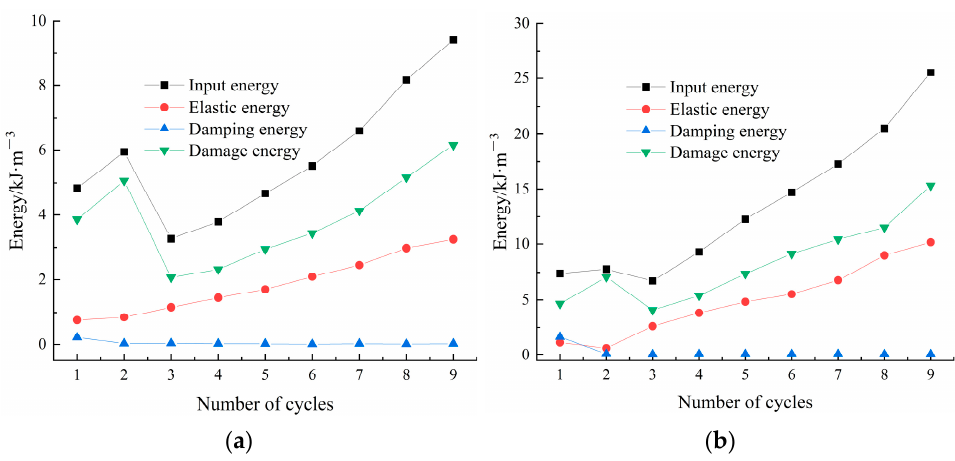
Figure 14. Rock energy evolution under VLLCL. ( a ) Sandstone; ( b ) granite.